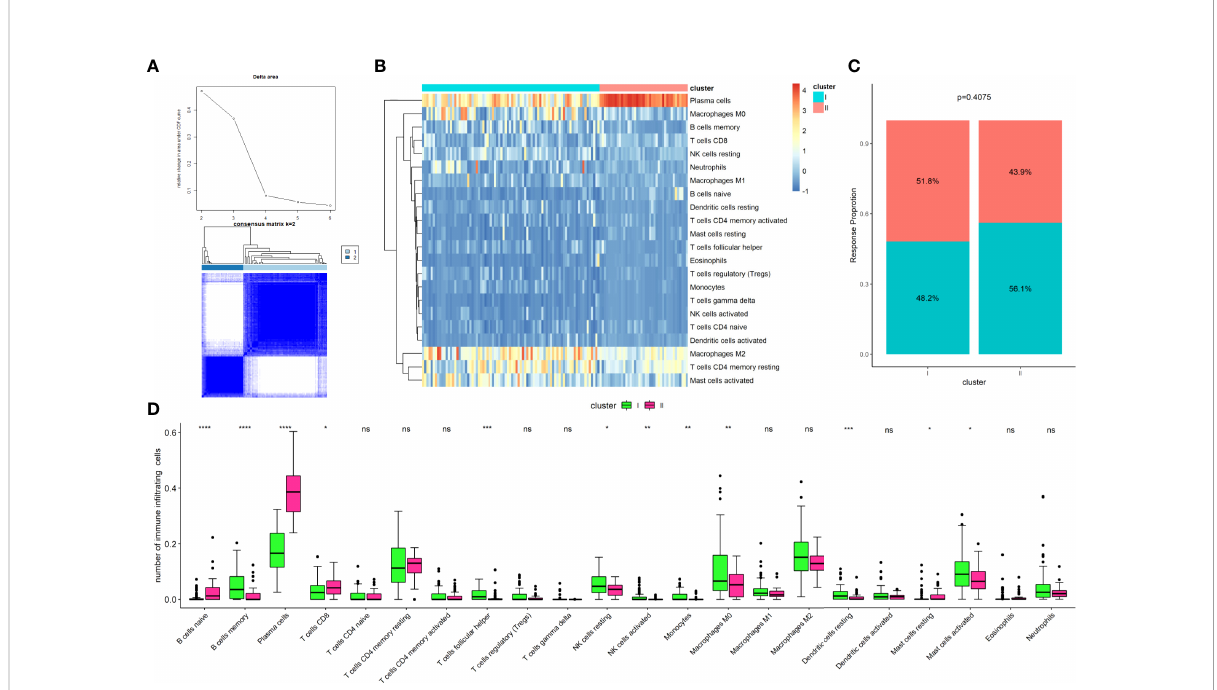
FIGURE 1 Establishment of clusters based on immune cells in fi ltrating fraction. (A) Unsupervised consensus clustering for the samples based on the TIICs infraction, with the k value as 2; (B) Clustering of the tumor-in fi ltrating immune cells; (C) Comparison of cluster frequency with the response status; (D) Comparison of tumor-in fi ltrating immune cells between Cluster I and Cluster II. *P < 0.05; **P < 0.01; ***P < 0.001; ns, not signi fi cant.